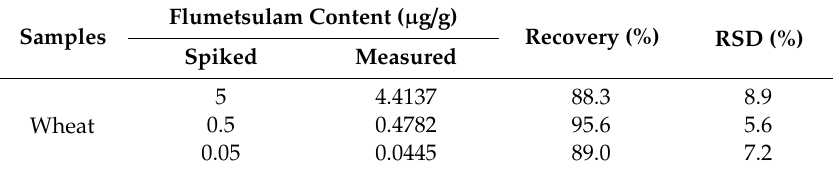
Figure 9. ( A ): SERS spectra of flumetsulam with di ff erent concentrations absorbed on the two-step modified concentrated AuNPs substrate. ( B ): The plot of the intensity of SERS peak at 786 cm − 1 versus the logarithm of flumetsulam concentration (5–1000 µ g / L. The error bars indicate standard deviations; 2 s and 3 s are the collecting time of SERS spectra). ( C ): The spectra of flumetsulam residue from extraction solutions of di ff erent concentrations spiked wheat samples with the proposed SERS method. ( D ): The plot of the intensity of the SERS peak at 786 cm − 1 versus the logarithm of flumetsulam concentration in wheat (0.05–5 µ g / g. The error bars indicate standard deviations). Table 1. Recovery test of flumetsulam in real wheat samples by the proposed SERS method (n =